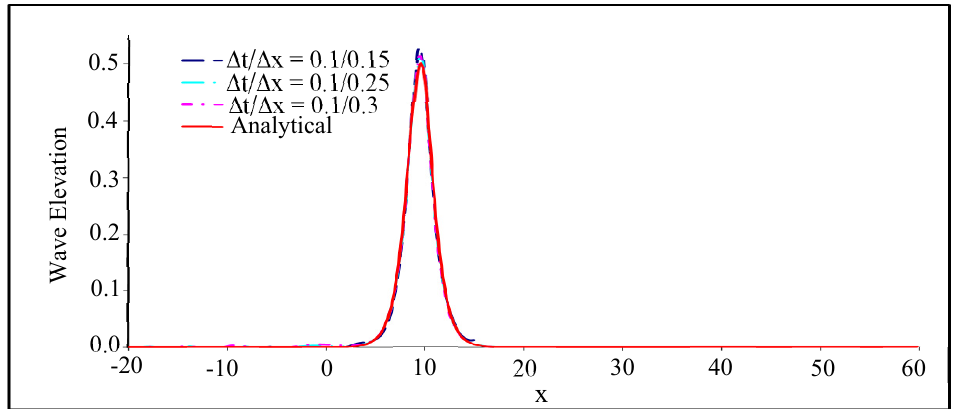
Figure A1. Comparisons of the numerical and analytical wave profiles using the grid size, Δ x, of 0.15, 0.25, and 0.3 with Δ t = 0.1 and dimensionless wave height = 0.5.